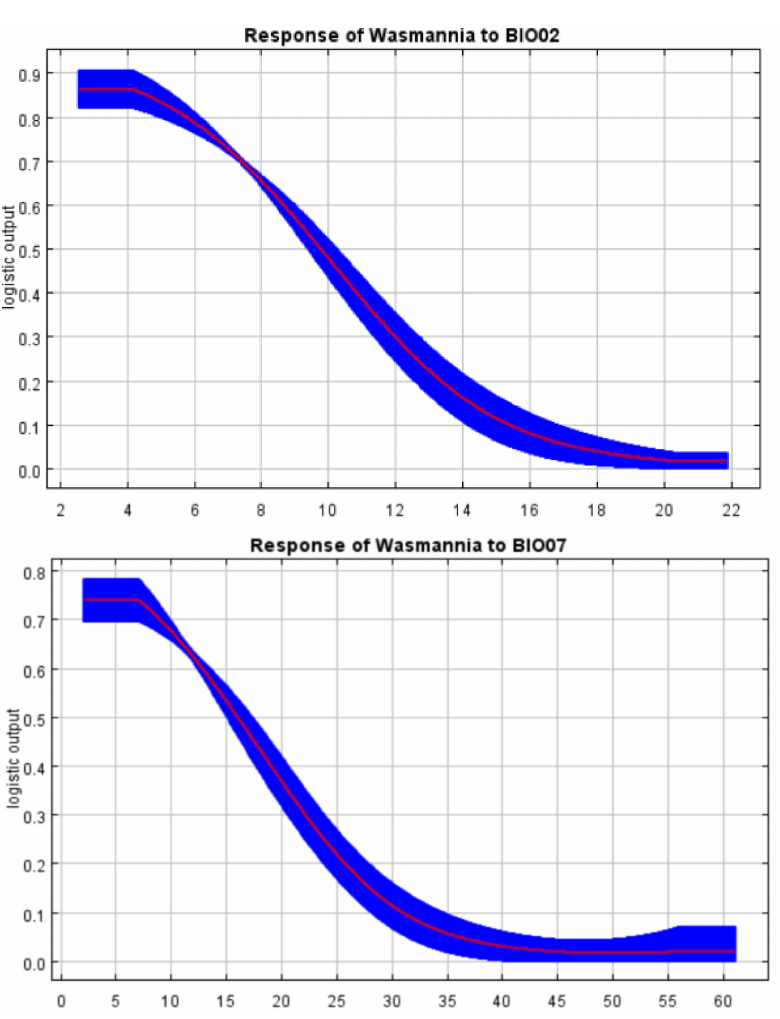
Figure 4. Response curve (BIO07, annual temperature range; BIO02, mean diurnal